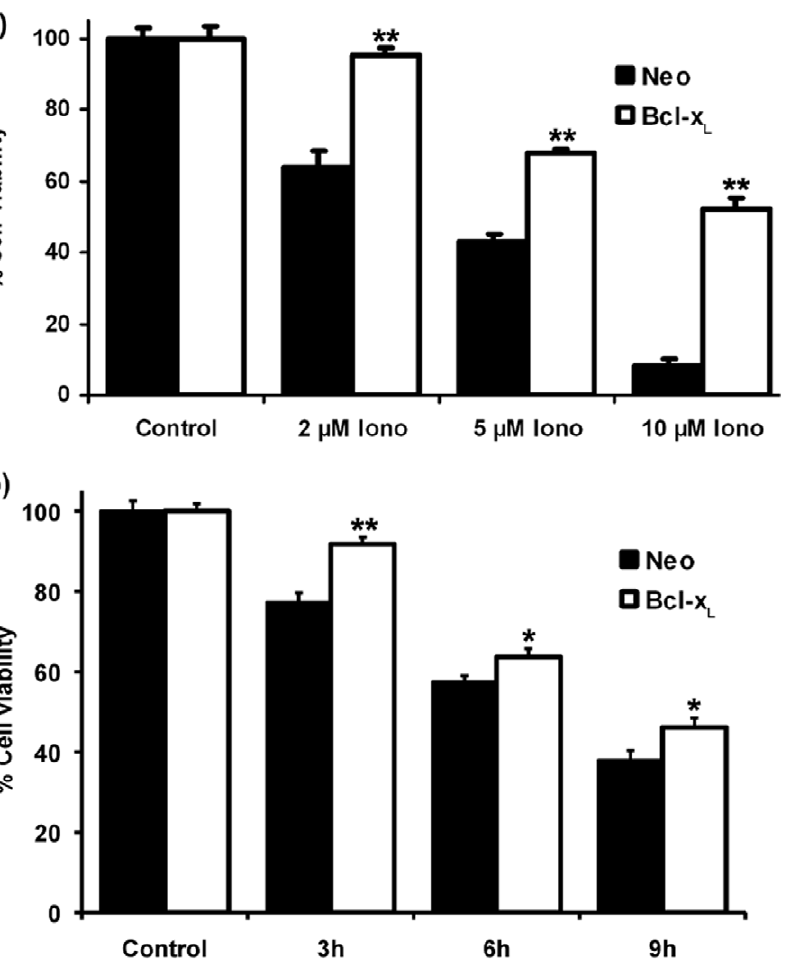
Figure 1. Effect of Bcl-x L over expression on ionomycin-induced death in SH-SY5Y cells. a) Cell viability of SH-SY5Y/Neo (black bars) and SH-SY5Y/Bcl-x L (white bars) cells treated with ionomycin for 3 hours at different concentrations. Afterwards, cell viability was determined using the MTT assay. Data represent mean 6 S.E.M. of 3 experiments carried on by quadruplicate. ***p , 0.001 as compared to control cells. b) Time-course of cell viability, determined by MTT assay, of SH-SY5Y/Neo (black bars) and SH-SY5Y/Bcl-x L (white bars) cells exposed to ionomycin (2 m M). Data represent mean 6 S.E.M. of 3 experiments carried on by quadruplicate. **p , 0.01, ***p , 0.001 as compared to control cells.